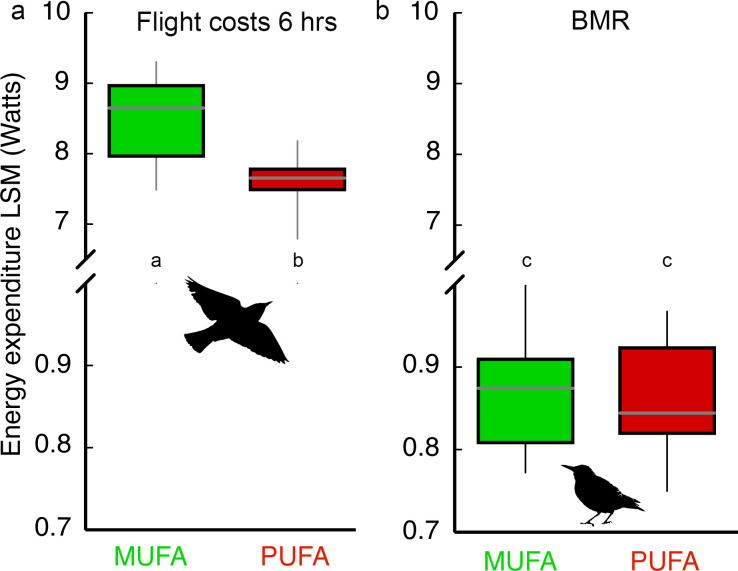
Dietary fatty acid manipulation affects flight costs but not costs of self-maintenance.Box plots (mean, 5% and 95% CI, range) for (a) Energy expenditure (measured with doubly labeled water) during a 6 hr ca. 260 km flight in a windtunnel for starlings (n = 33) fed one of two diets (n = 16, 17) and after 15 days of flight-training. Body mass was used as a covariate in the ANCOVA comparison of diet effects on energy expenditure, and (b) Basal metabolic rate (BMR; measured using open-flow respirometry) of MUFA- (n = 19) and PUFA-fed (n = 17) European starlings that were flight-trained or sedentary. Means with different letters within each panel are significantly different (p<0.05).